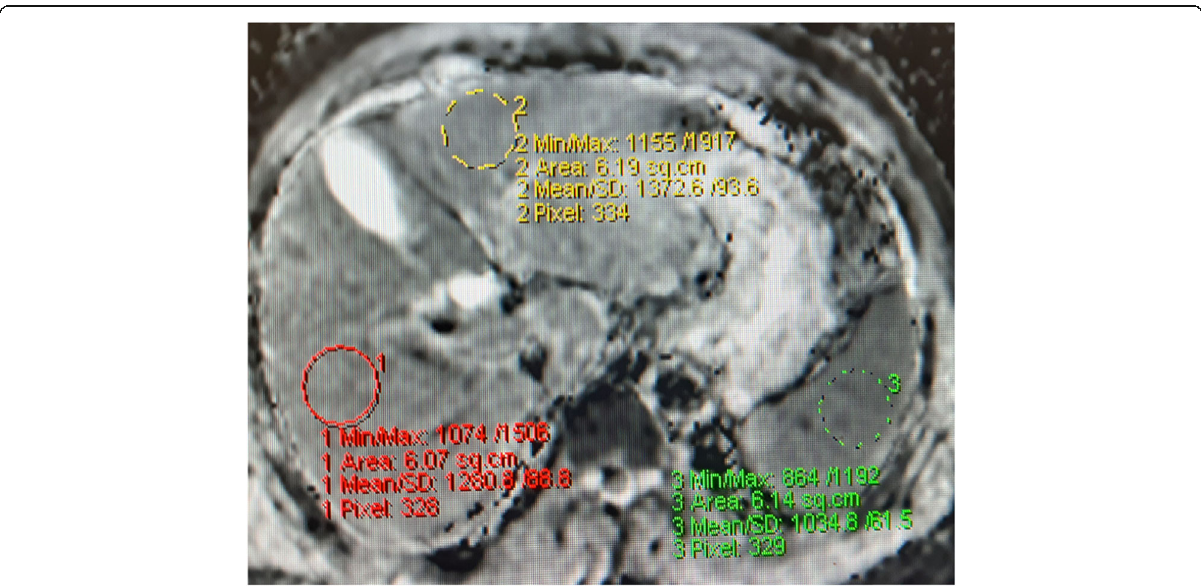
Fig. 1 DW-MR ( b = 800) image and ADC map of the liver and the spleen for a case of F2 stage [mean liver ADC value = 1376.3 mm 2 /s, mean